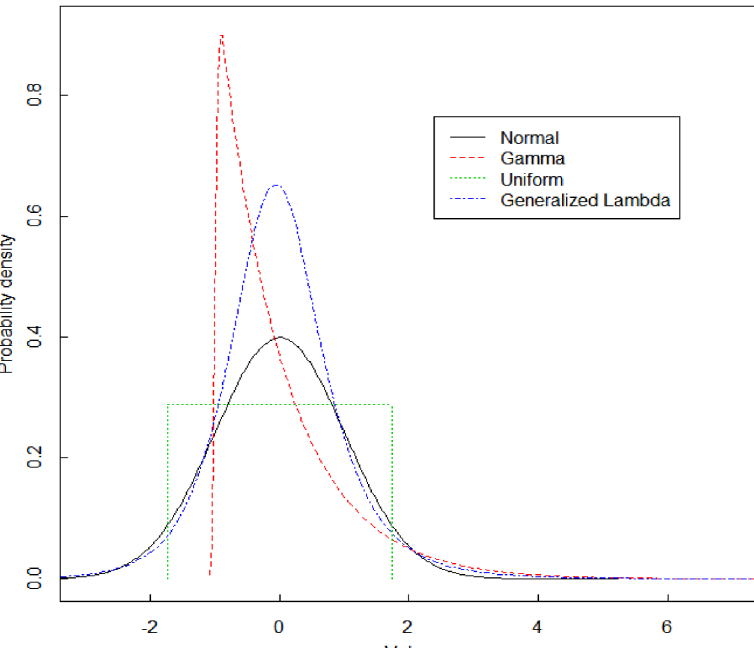
Fig. 5. Four example measurement error probability densities: normal, gamma, uniform, and generalized lambda, each with mean 0 and variance